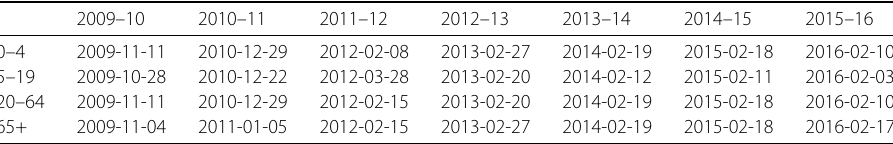
Table 3 The influenza peak weeks for each age-group. Here, we record Wednesday of that week. Except for the 2011–12 season when the height of the second peak of 5–19 age-group in the bimodal peak was higher than that of the first peak, the 5–19 age-group peaks earlier than the other